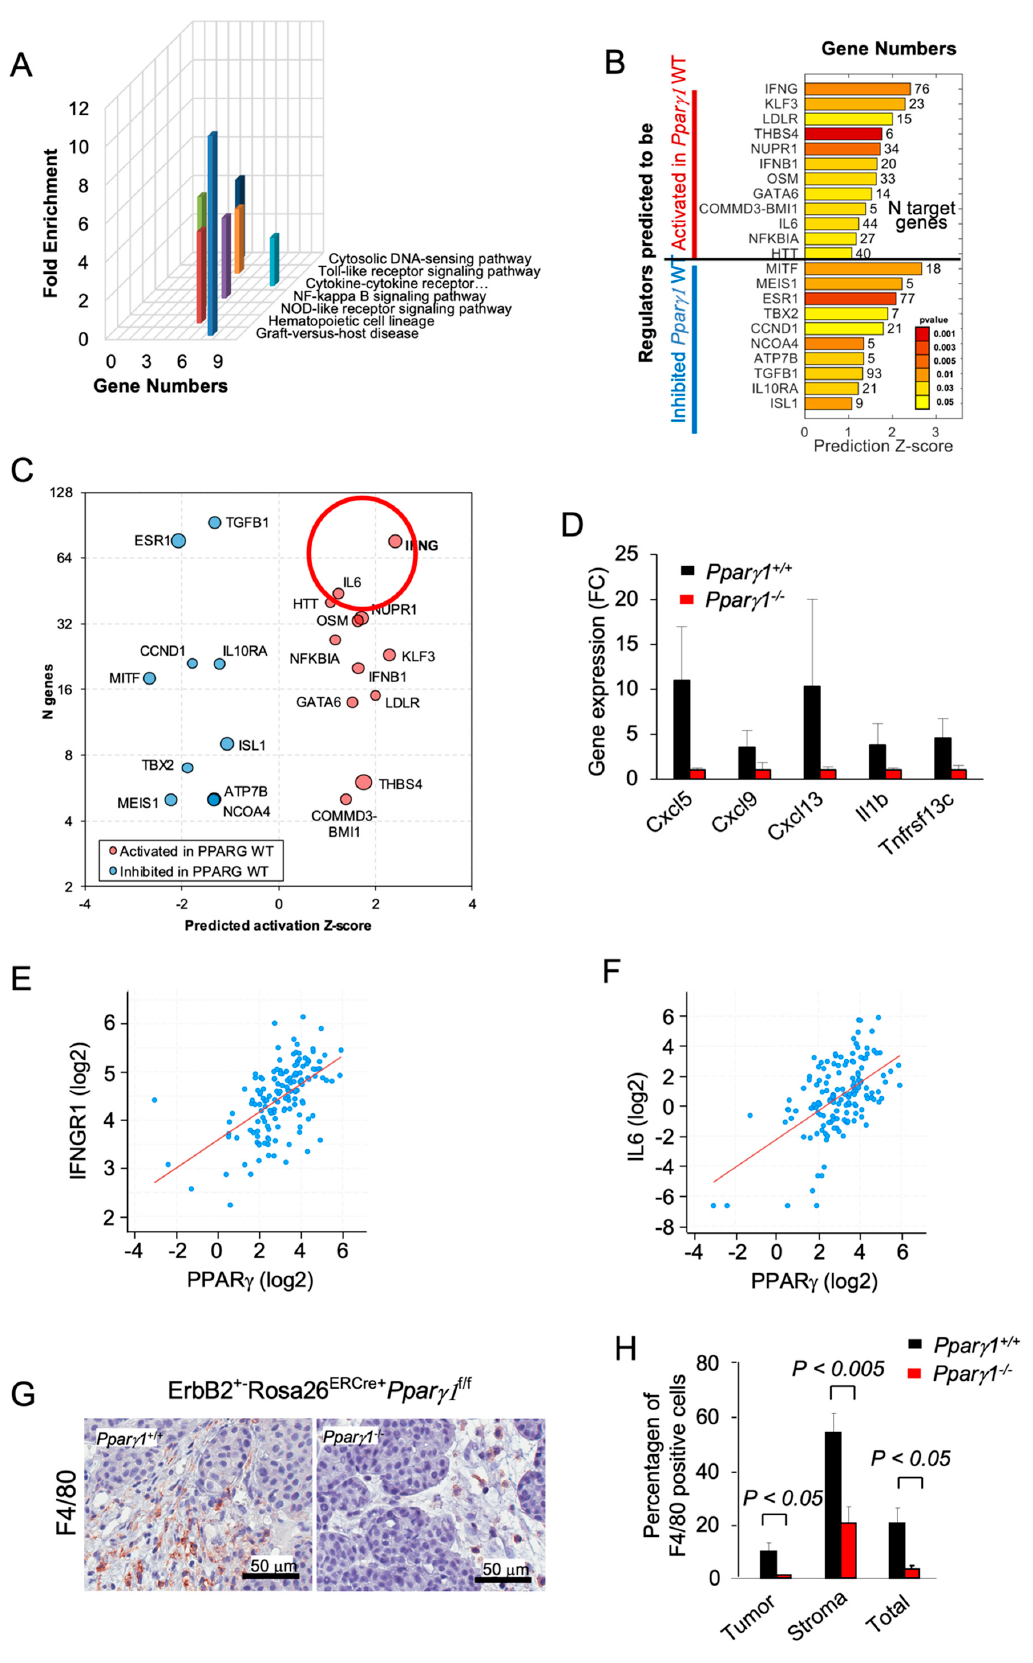
Figure 3. Deletion of Ppar γ 1 in MMTV-ErbB2 mammary tumors reduces gene expression of signaling via cytokine/chemokine and growth factor pathways. ( A ). KEGG pathway analysis gene expression from tumors of ErbB2 mammary GEMM